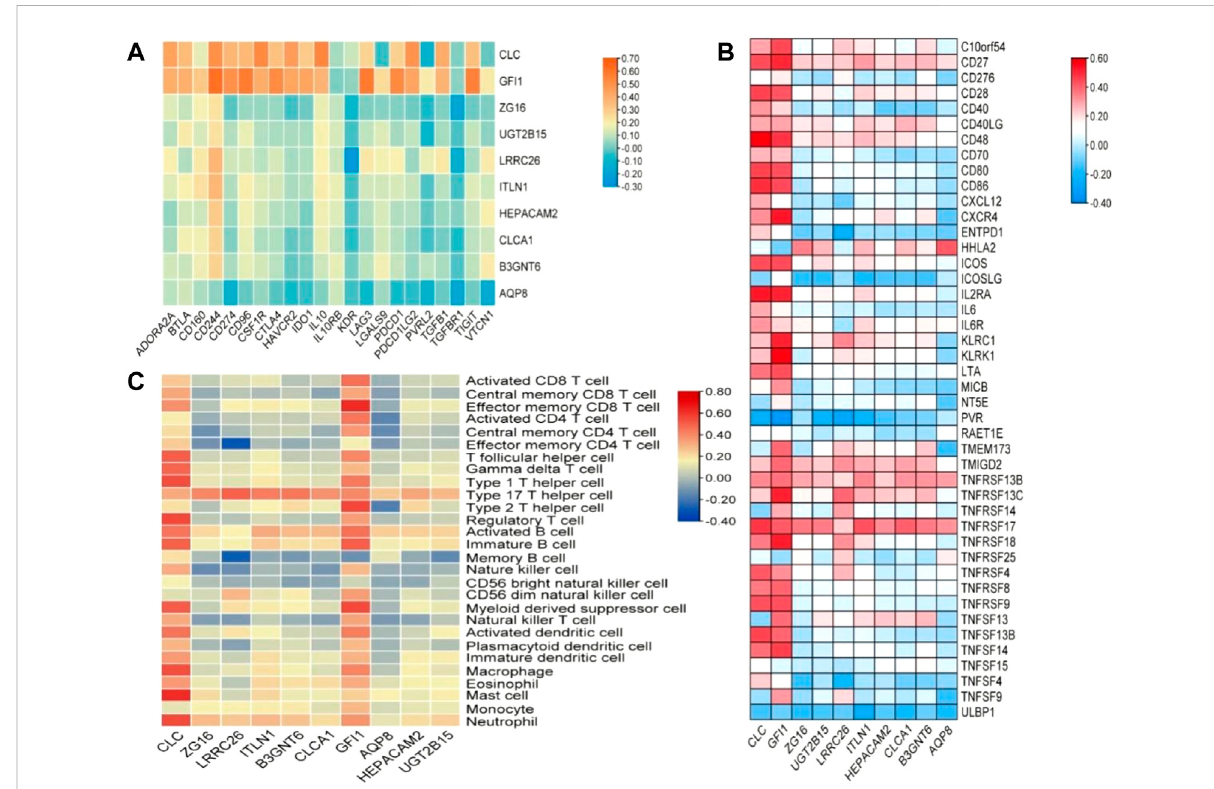
FIGURE 8 The relationship betweenDEGsand immunomodulator. (A) The relationship between DEGs andimmunoinhibitor, (B) therelationshipbetween DEGs and immunostimulator, and (C) relations between abundance of tumor-in fi ltrating lymphocytes (TILs) and expression of